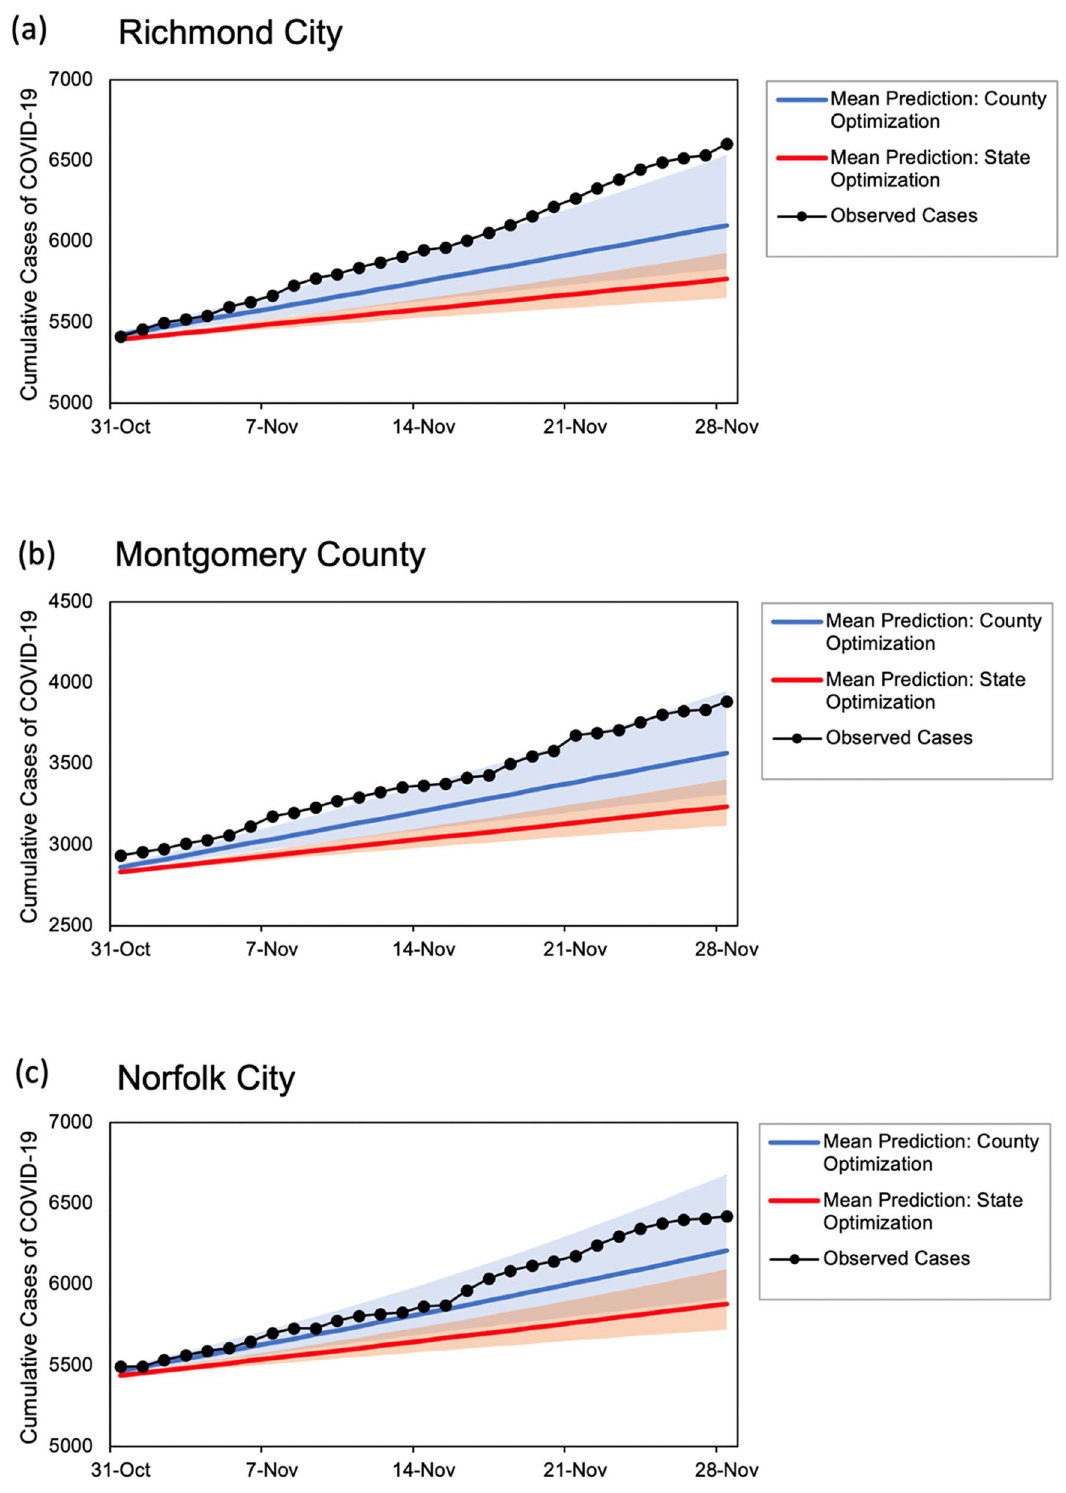
Figure 3. COVID-19 case projection comparison between state and county optimization for three localities in Virginia: ( a ) Richmond City; ( b ) Montgomery County; and ( c ) Norfolk